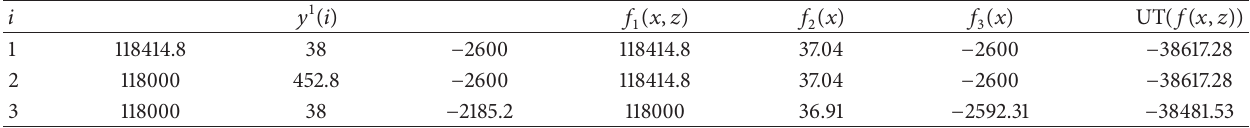
Table 5: The efficient points obtained at the second iteration according to the perturbed reference points.